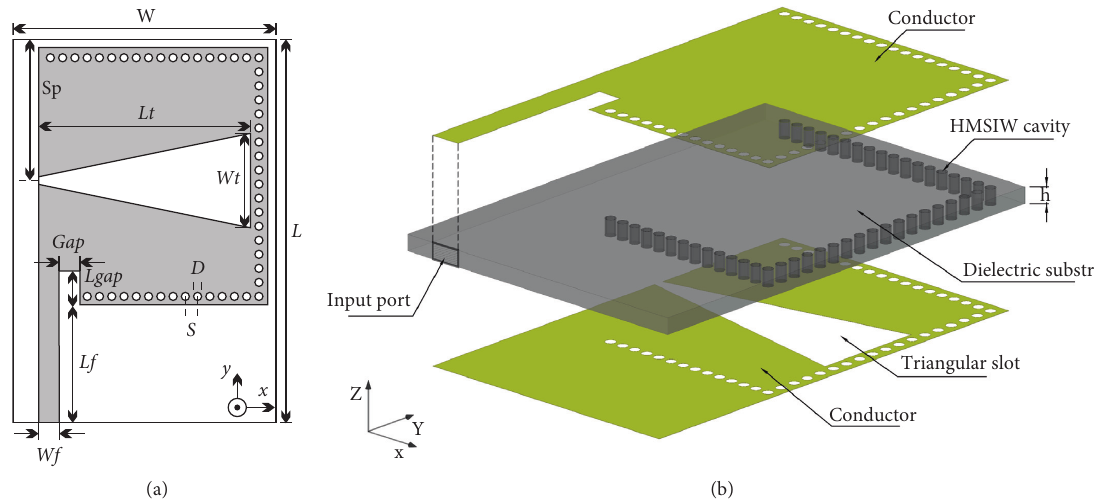
Figure 1: (a) HMSIW-CBS antenna with hybrid resonances using a triangular slot ( W � 31mm, L � 45.5 mm, D � 1mm, Sp � 16.75mm, Lt � 25mm, Wt � 11mm, Gap � 2.5 mm, Lgap � 4 mm, Lf � 14 mm, and Wf � 2.425mm). (b) Explode view of the proposed HMSIW-CBS antenna.